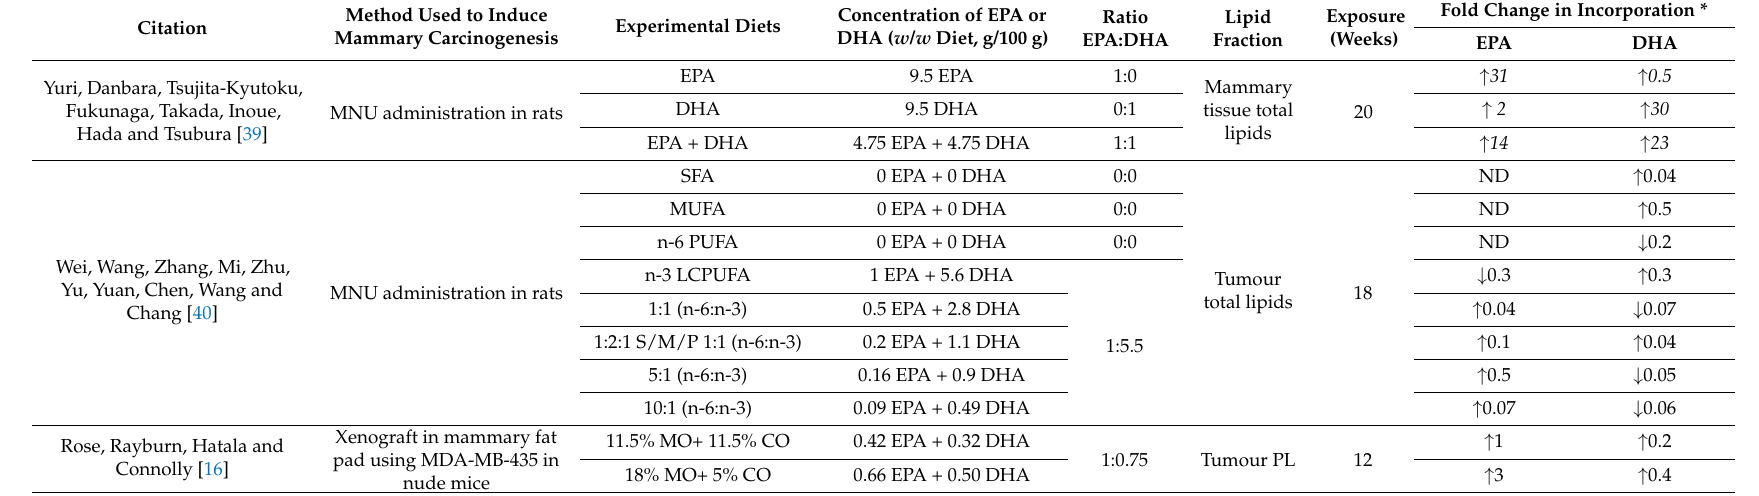
Table 2. Incorporation of EPA and DHA measured in the plasma membrane when feeding EPA:DHA mixtures in rodent models of human